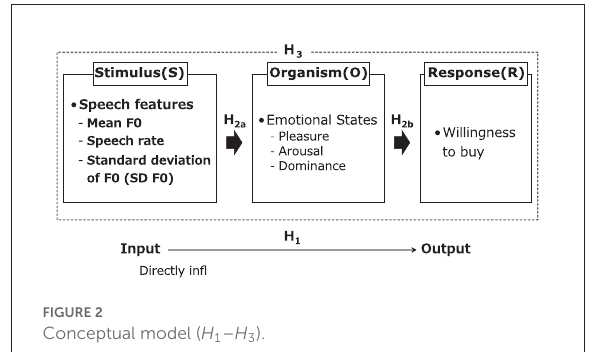
FIGURE2 Conceptual model ( H 1 – H 3 ).